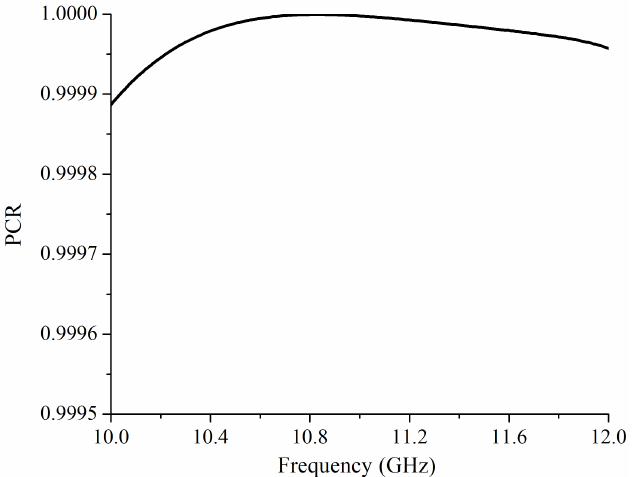
Figure 3. The simulated polarization conversion